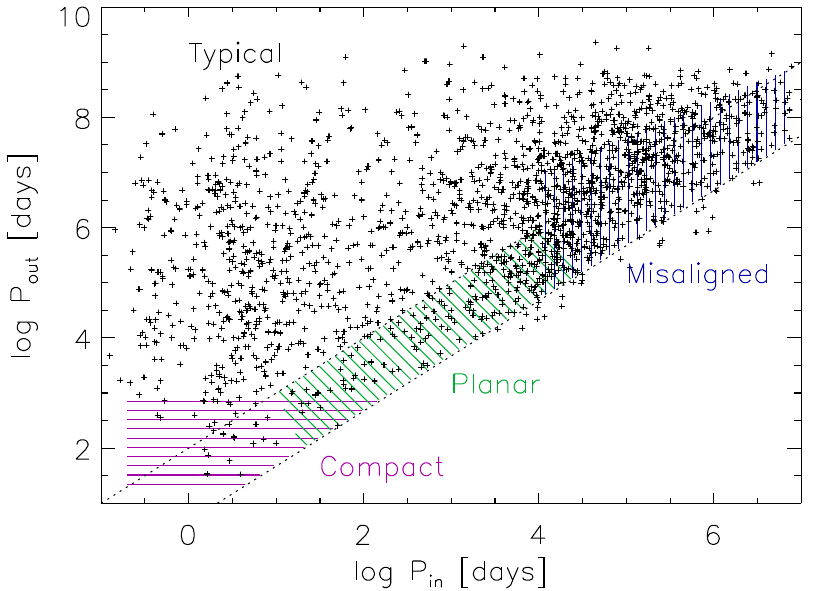
Figure 3. Periods of the inner and outer binaries at adjacent hierarchical levels for known multiples within 200 pc. The dotted lines correspond to the period ratios of 4.7 and 100. The hatched areas indicate approximate locus of different classes discussed further in Section